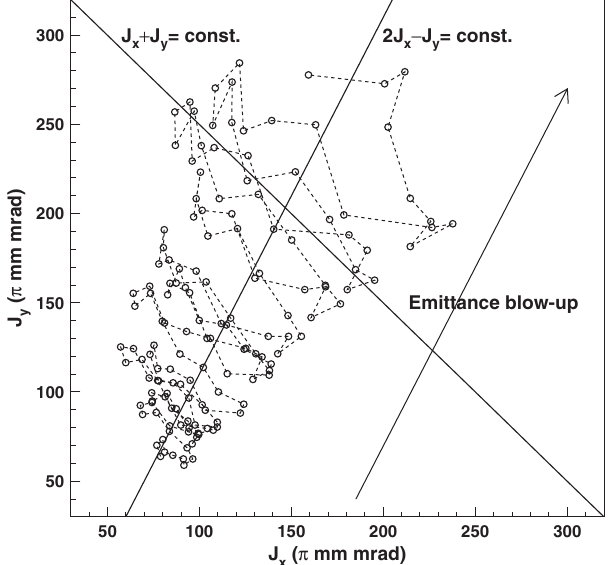
FIG. 34. Typical sample of the incoherent motion of one macro- particle which results in the beam halo found in Fig. 32(b); two- dimensional plot of the tune-by-turn betatron actions ( J x , J y